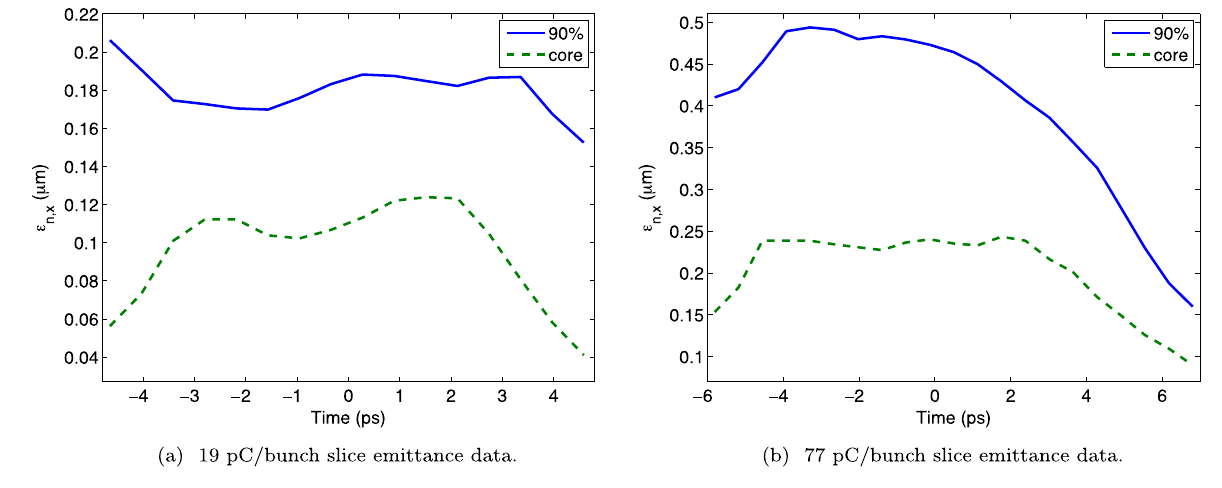
FIG. 17. The 90% and core slice emittance for (a) 19 pC = bunch and (b) 77 pC = bunch